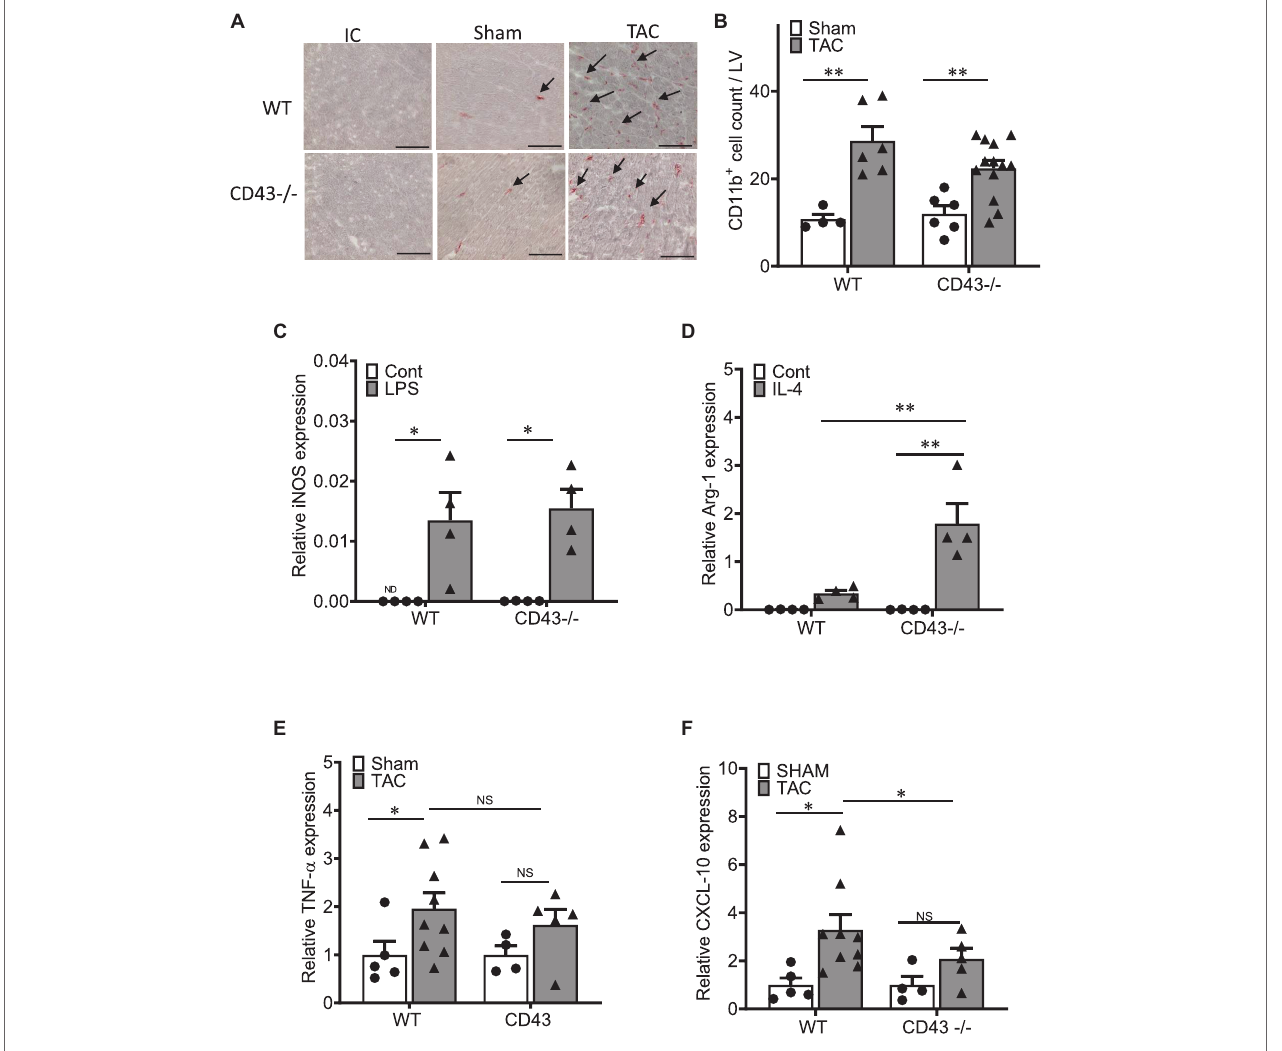
FIGURE 4 | CD43 modulates monocyte polarization toward M2 macrophages in vitro , and cardiac CXCL10 expression in response to TAC in vivo . (A) Representative CD11b staining images of WT and CD43 − / − heart sections from TAC and Sham animals. (B) Quantification of CD11b infiltrates in WT and CD43 − / − Sham and TAC LV across the whole heart section. IC is isotype control; arrows indicate immune reactivity for CD11b antibody. Scale bars, 100 μ m. (C,D) qPCR quantification of inducible nitric oxide synthase (iNOS; C ) and Arginase I (Arg-1; D ) in untreated and LPS (C) or IL-4 (D) treated bone marrow (BM) derived monocytes from WT and CD43 − / − mice after 72 h of stimulation. (E,F) qPCR quantification of TNF α (E) and CXCL10 (F) of WT and CD43 − / − hearts harvested 4 weeks after Sham or TAC surgery. * p ≤ 0.05; and ** p ≤